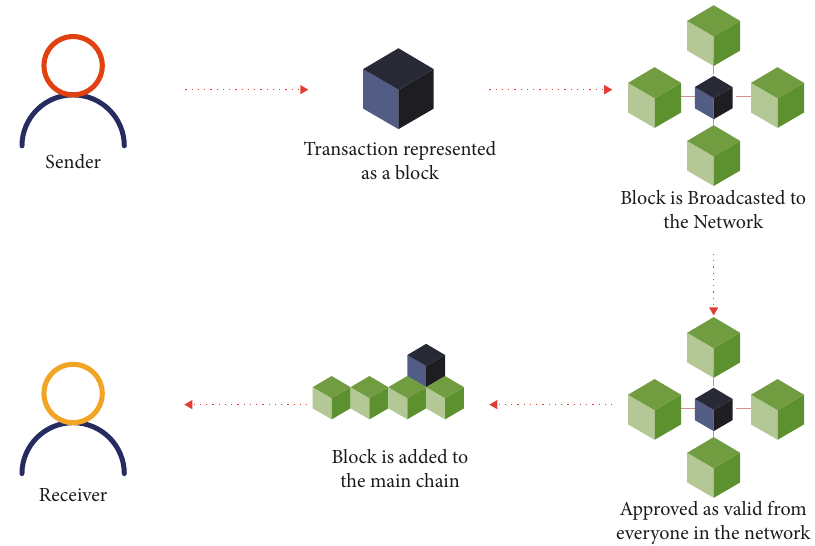
Figure 1: The basic structure of blockchain